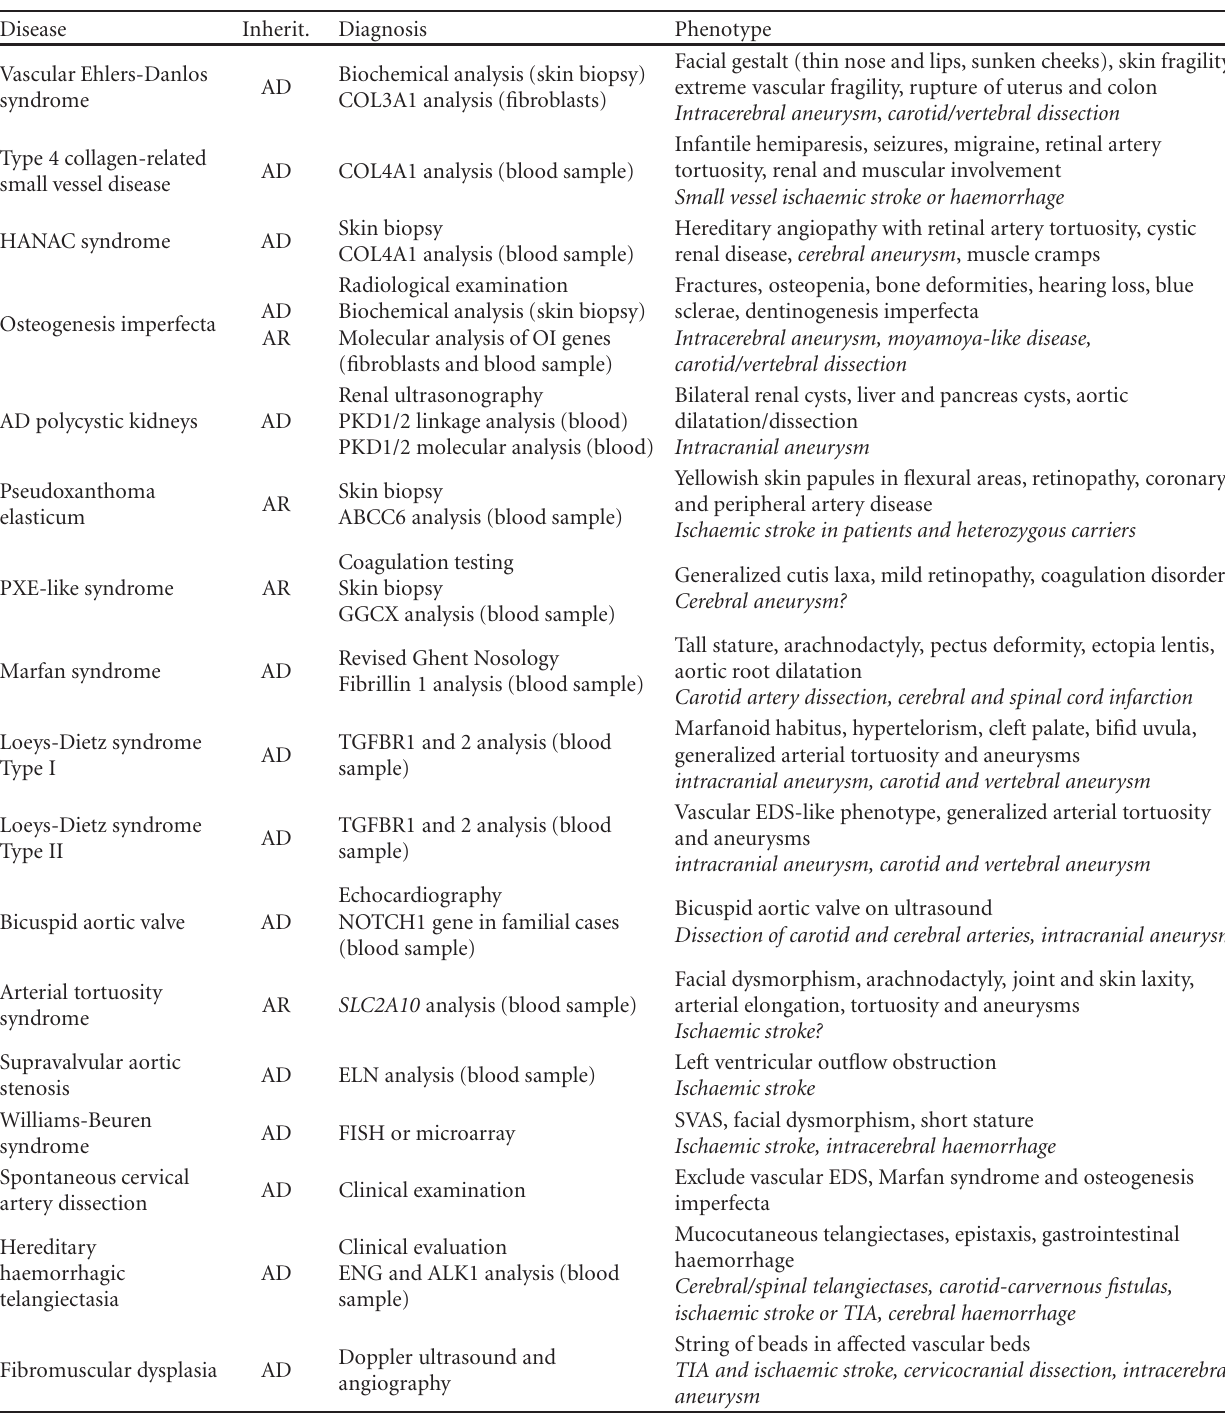
Table 3: Summary of the most important connective tissue diseases related to stroke in young